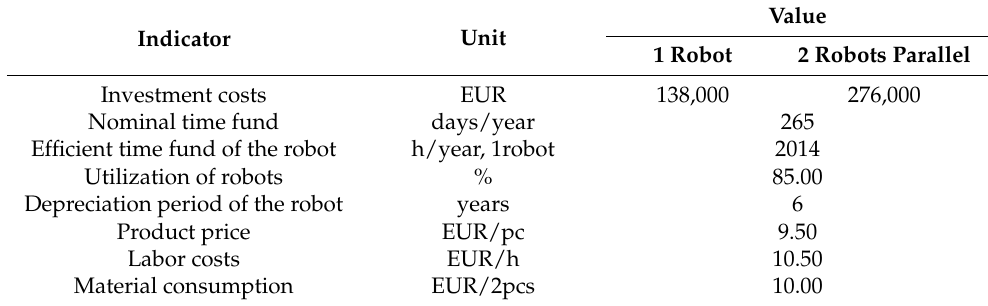
Table 5. Selected input data for assessing the economic efficiency of investment variants.